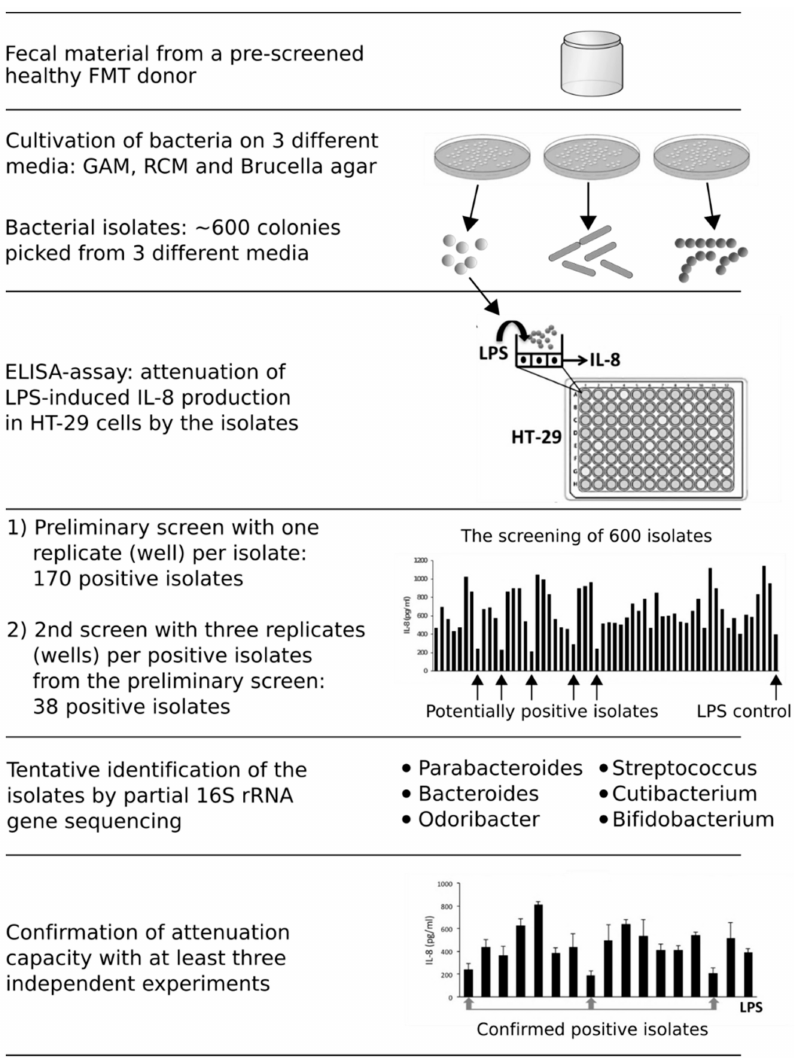
Figure 1. The high-throughput approach to screen for anti-inflammatory bacteria and the outcomes from di ff erent